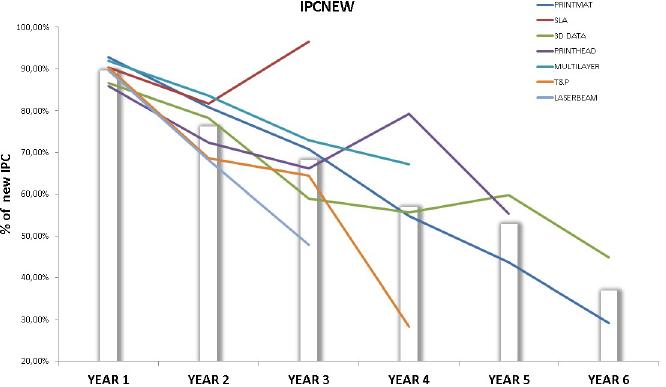
Fig 15. IPCNEW for each technology front. This figure shows the evolution of IPCNEW indicator for each technology front. Data points above the bars indicate higher than average incorporation of new IPC’s to the technology